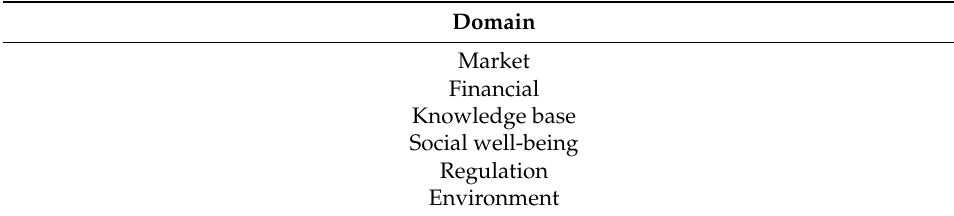
Table 1. Main domains for the MCDM